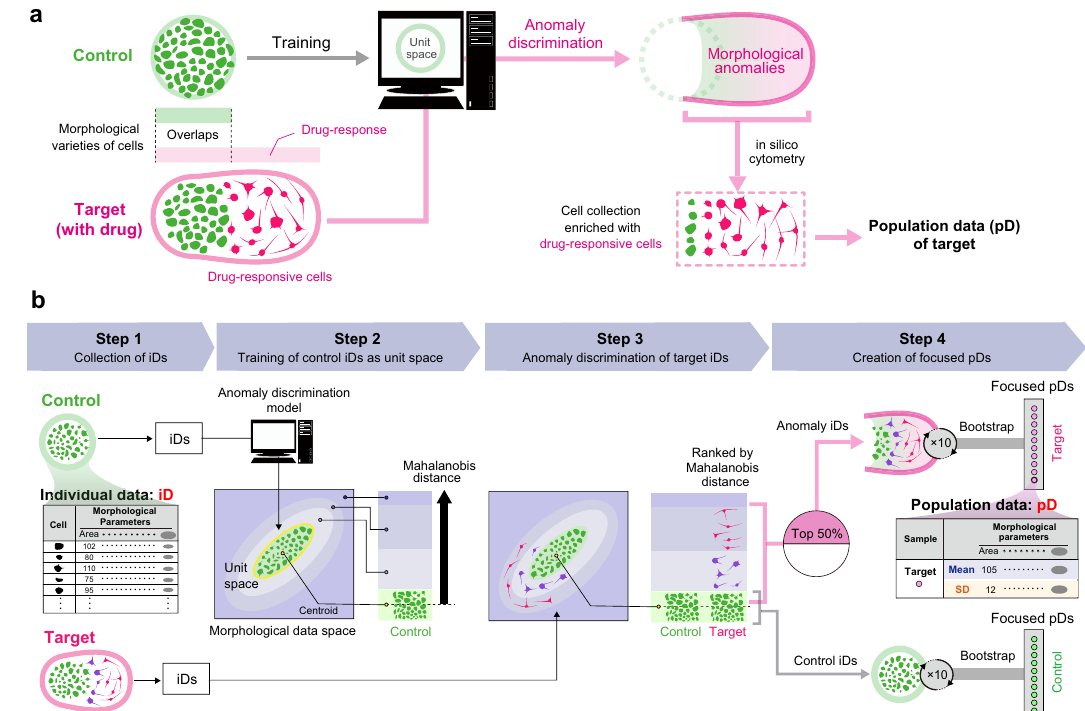
Figure 1. Schematic illustration of in silico featured-objects concentrated by anomaly discrimination from unit space (in silico FOCUS) analysis. ( a ) The concept of in silico FOCUS. This algorithm uses morphological variations in the control status for training the anomaly discrimination model and discriminates the “drug- responsive cells” as “morphological anomalies appeared in target status (with drug).” Collecting such morphological anomalies using in silico cytometry enables the collection of individual cell data with enriched drug-responsive cells to create population data (pD) to represent the target. ( b ) Steps in the data processing for in silico FOCUS. Step 1: individual data (iD) of cells, which are measured data of 14 morphological parameters, are collected. Step 2: Using only control iDs, unit space is trained for the anomaly discrimination model. In the anomaly discrimination model, unit space is placed in the center of morphological data space. The distance from the unit space is described by Mahalanobis distance. Step 3: Target iDs are ranked in the order of Mahalanobis distance by the discrimination model. Step 4: Using bootstrap, control-focused pDs are collected from total control iDs, while target-focused pDs are collected from anomaly iDs. All illustrations created